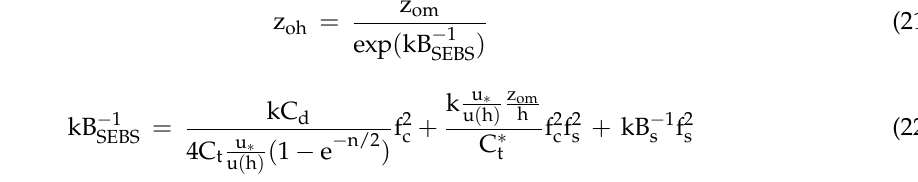
Thematic Mapper plus (ETM+) on Landsat 7. The two Landsat scenes were obtained from the National Snow and Ice Data Center